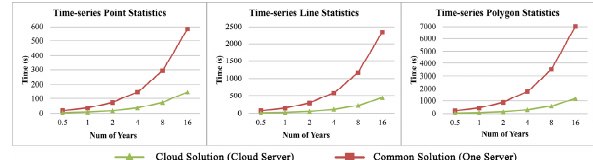
Figure 6. Comparison of time-series statistics between cloud solution and common solution